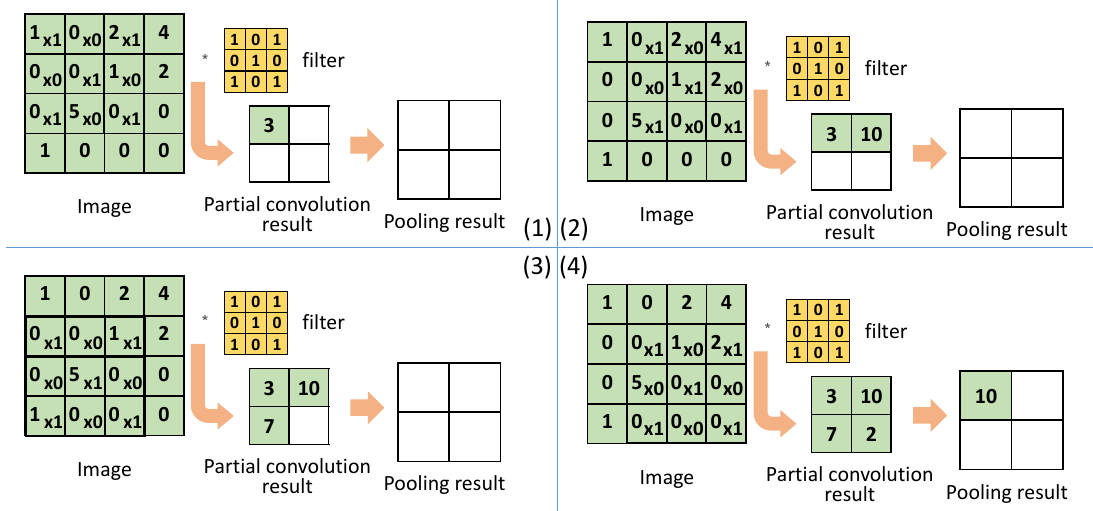
Figure 12. Operation order of combine convolution and pooling layer.